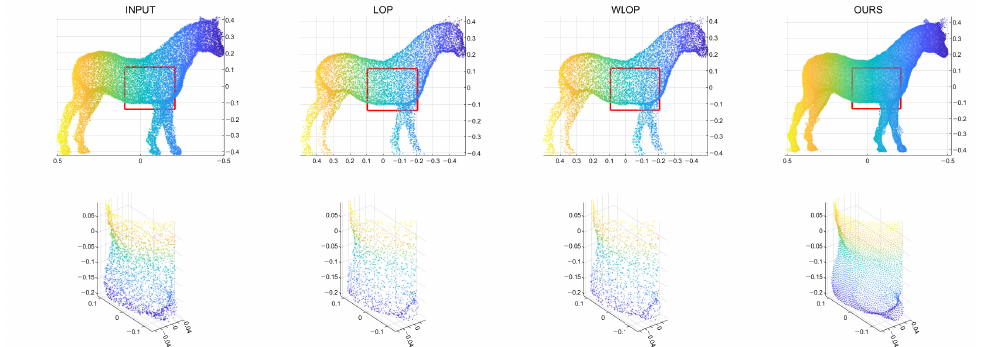
Figure 15. Qualitative results for an tangential noise case with resampling ratio 2.0 (Horse). First column: input point cloud; second column: LOP; third column: WLOP; and fourth column: the proposed method. The second row shows enlarged views of the first row.